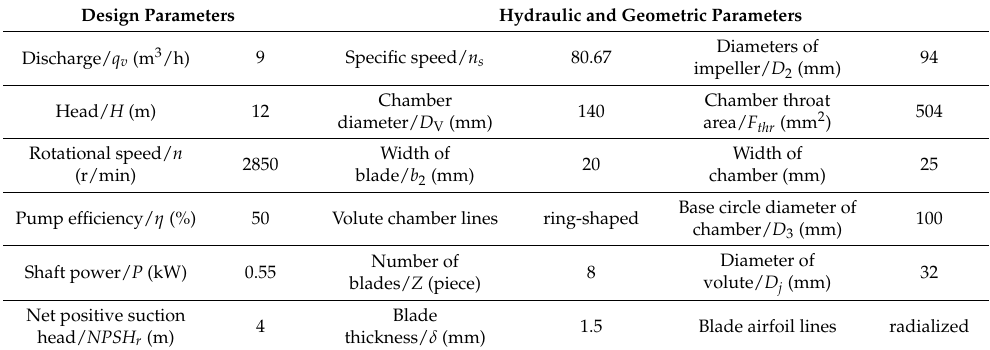
Table 1. Vortex pump design and hydraulic parameters.